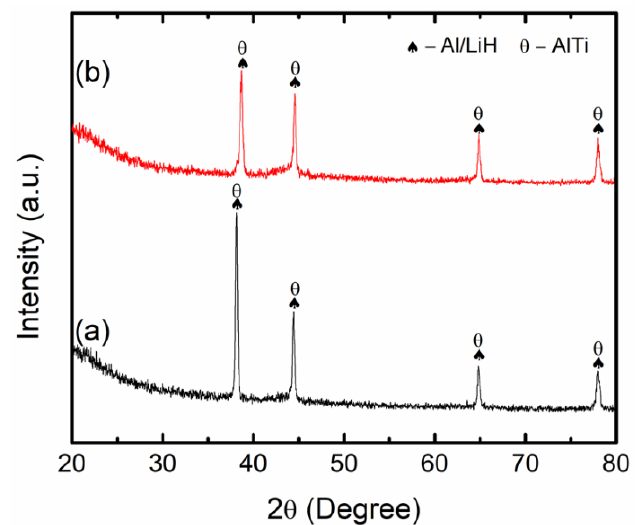
Figure 10. The XRD profile of ( a ) LiAlH 4 + 10 wt.% CoTiO 3 and ( b ) LiAlH 4 + 20 wt.% CoTiO 3 after desorption at 250 °C.